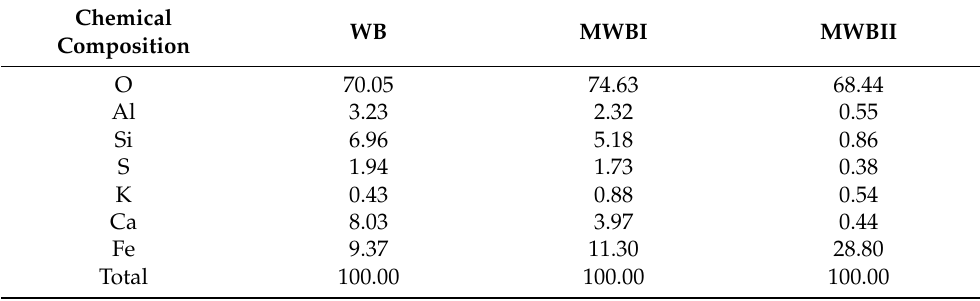
Figure 1. SEM-EDX analysis, images details, and mapping of Fe on the samples ( a ) WB, ( b ) MWBI, and ( c ) MWBII. Table 2. The chemical composition of WB, MWBI, and MWBII in atomic % determined by EDX analysis.